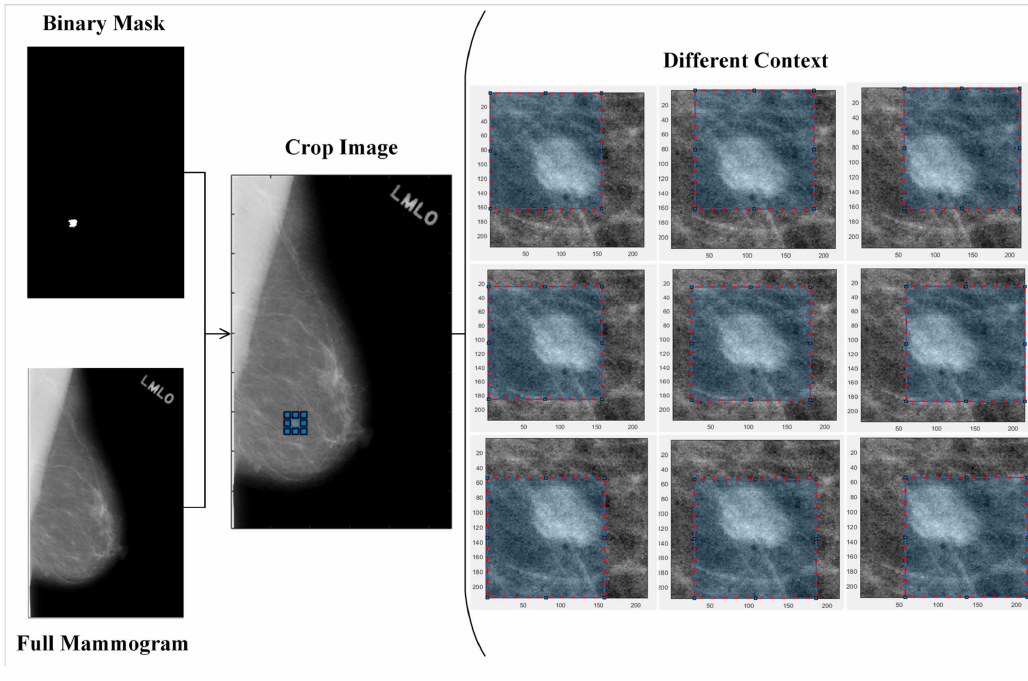
Figure 11. Extracted ROI with different contexts.